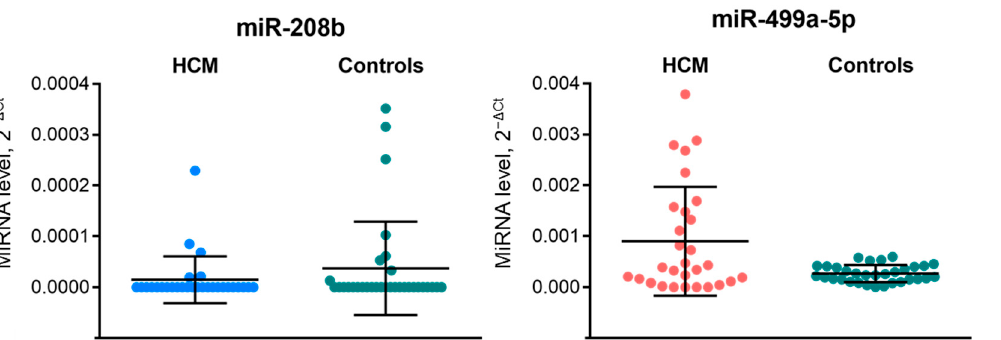
Figure 2. Plasma levels of miR-208b and miR-499a-5p in 29 HCM patients and 32 healthy controls as determined by RT-qPCR. Here and below, miRNA levels were calculated relative to cel-miR-39-5p using the delta-delta Ct method. Data is presented using a scatter plot (mean with SD). Differences in miRNA levels between HCM patients and healthy controls were insignificant ( p > 0.05) according to a Mann-Whitney U test. The green dots define levels of miR-208b and miR-499a-5p in controls, blue dots and red dots—levels of miR-208b and miR-499a-5p, respectively, in patients with HCM. HCM—hypertrophic cardiomyopathy.